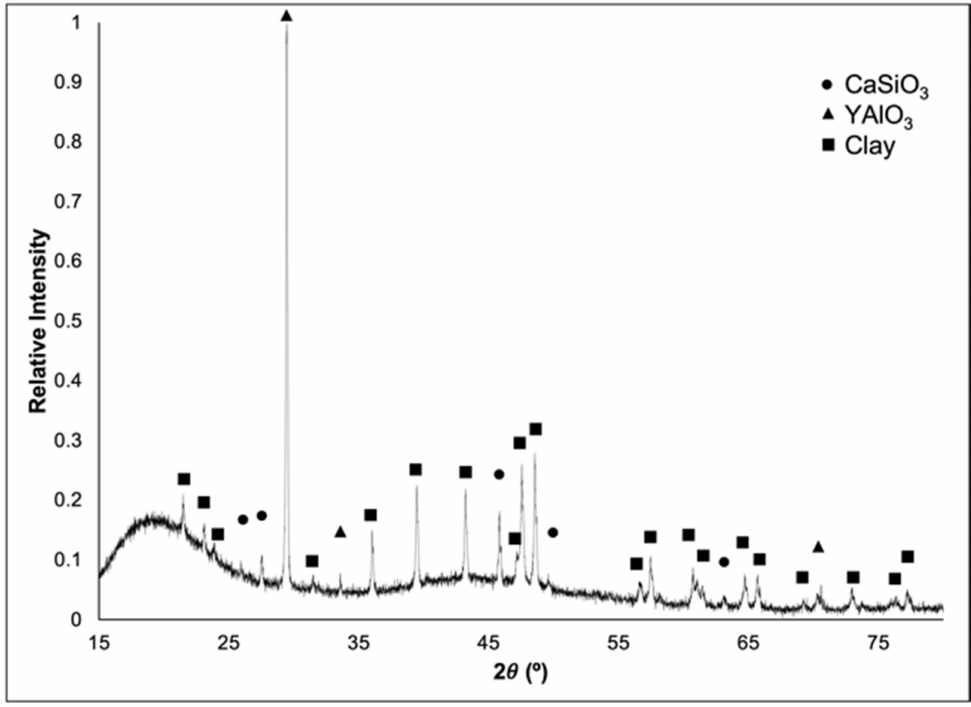
Figure 3. XRD pattern collected from the surface of the (100) YAP/CMAS reacted sample after 10 min at 1350 ◦ C (same sample as shown in Figure 2). Diffraction peaks for YAlO 3 and CaSiO 3 were identified and labeled accordingly. All other remaining peaks matched those of the clay that was used for XRD mounting and had been scanned